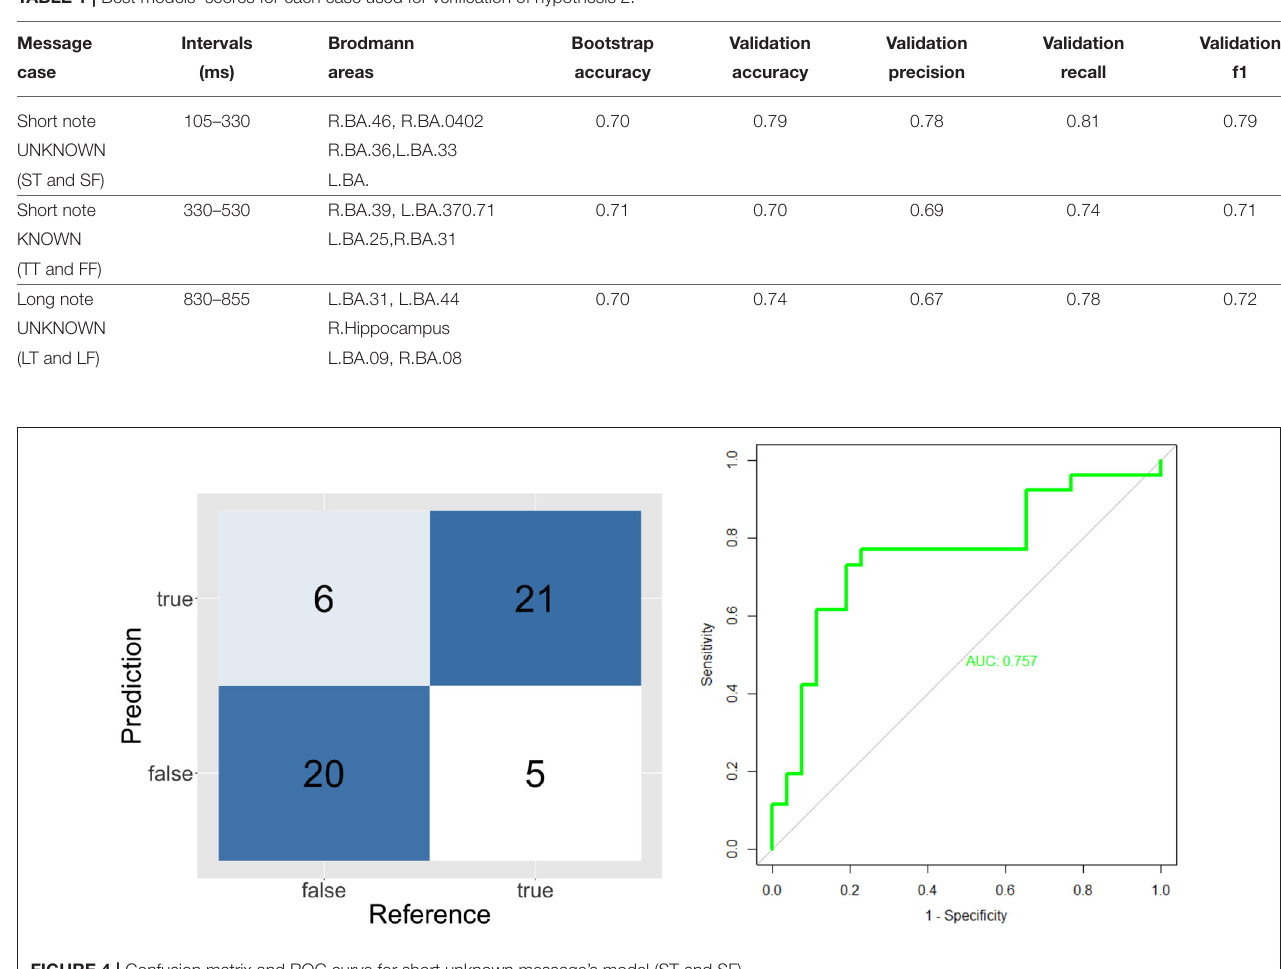
FIGURE 4 | Confusion matrix and ROC curve for short unknown message’s model (ST and SF).